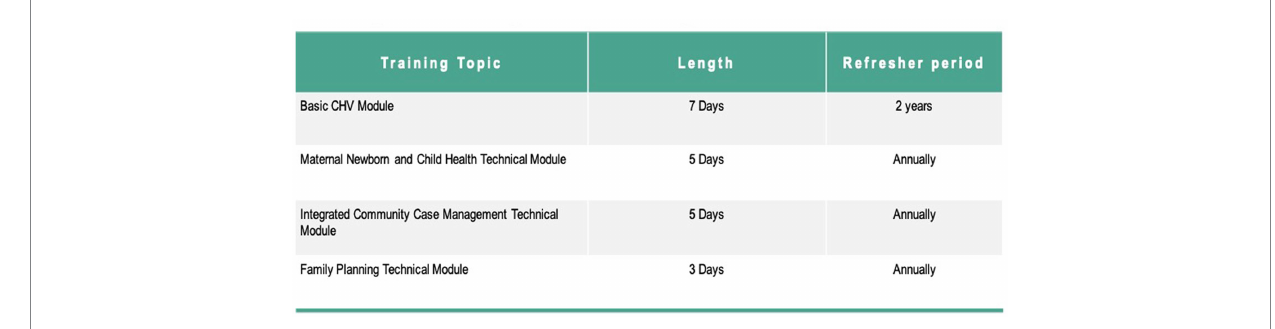
FIGURE 3 Training topics. All training was based on Kenya’s national curriculum for